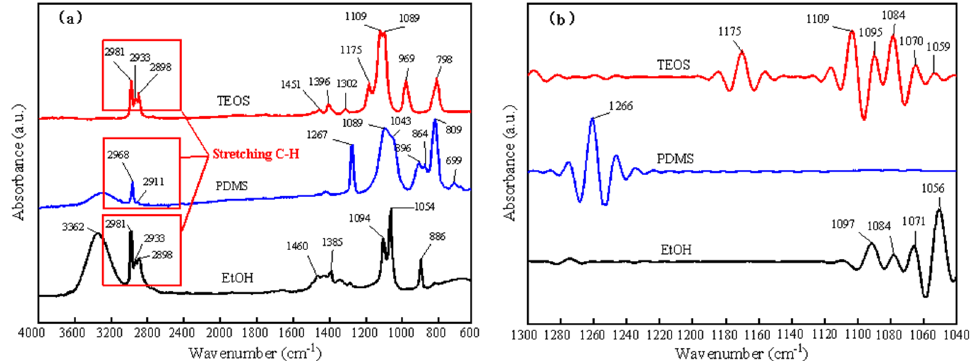
Figure 2. FTIR spectra. ( a ) FTIR spectra of TEOS, PDMS, and EtOH. ( b ) Fourier self-deconvoluted infrared spectra of TEOS, PDMS, and EtOH at 1040 cm − 1 to 1300 cm − 1 . Table 1. Antisymmetric stretching, symmetric stretching, and bending peaks of C-H bonds in TEOS, PDMS, and EtOH.